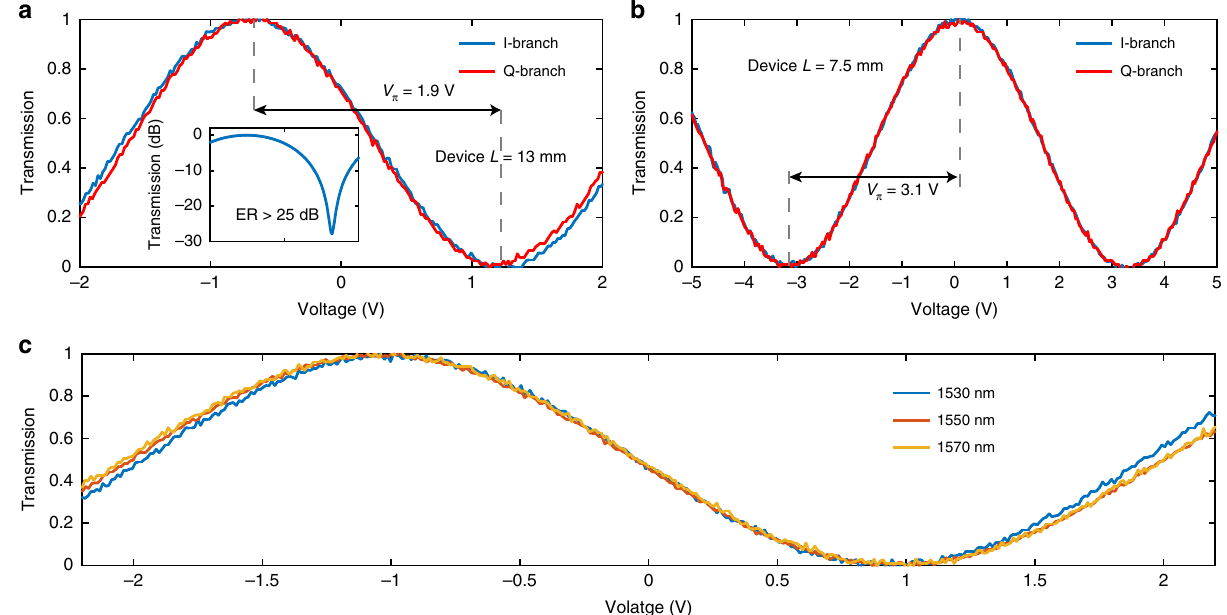
Fig. 3 Static EO characteristics. a , b Normalised optical transmission of both branches of the 13-mm and 7.5-mm devices as a function of the applied voltage, showing V π of 1.9 V and 3.1 V, respectively. The inset of a shows the measured normalised transmission on a logarithmic scale, showing an extinction ratio greater than 25 dB. c Measured optical transmission at different wavelengths.